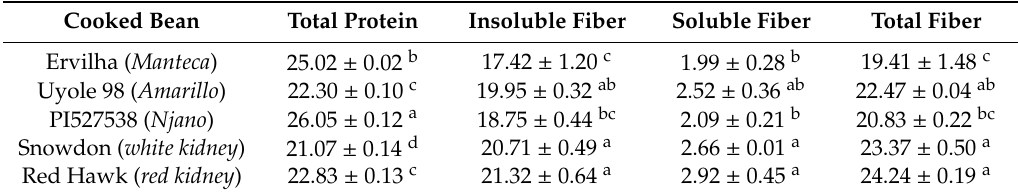
Table 3. Protein and Fiber Concentrations (g / 100 g) of Cooked Beans Used to Formulate Bean Based Diets. 1